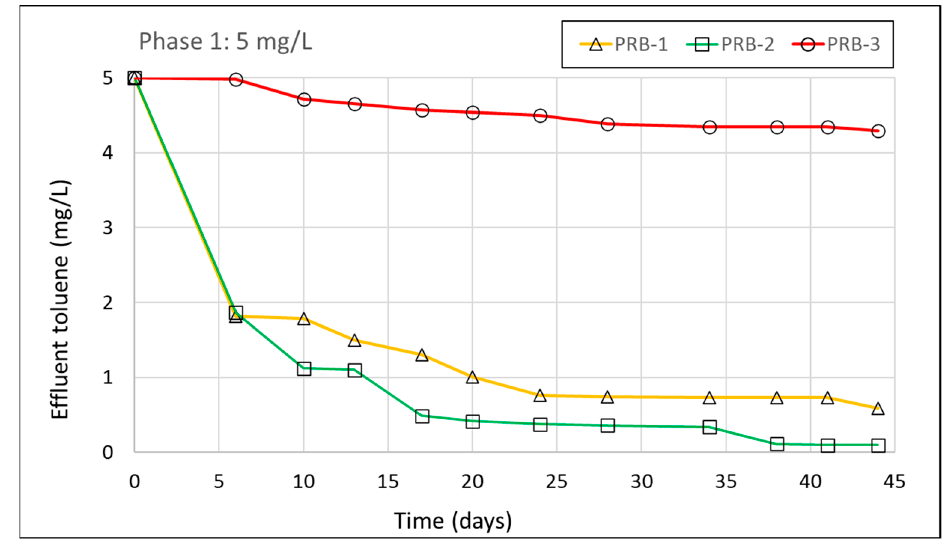
Figure 2. Changes in toluene concentrations in the PRB columns for phase 1.